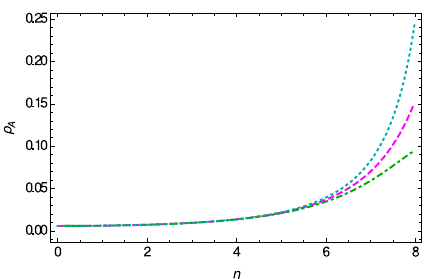
Fig. 19 Variation of ¯ ζ (left panel) and of the Higgs-type potential ¯ V (ζ) (right panel) for three-form quark stars as functions of η , for ¯ a = 0 . 01 and for three different values of the constant ¯ b : ¯ b = 0 (dashed curve), ¯ b = − 0 . 11 (dotted curve), and ¯ b = 0 . 11 (dot-